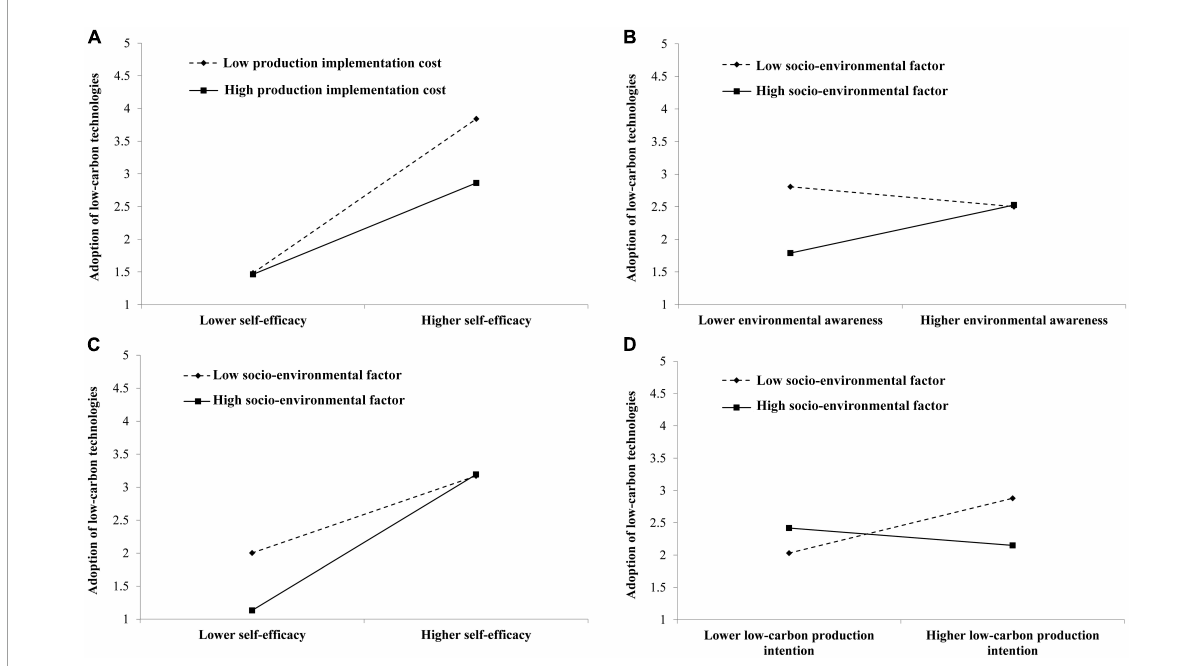
FIGURE4 Moderating effects of production implementation cost and socio-environmental factor. (A) Production implementation cost moderates the effect of self-efficacy on the adoption of low-carbon technologies. (B) Socio-environmental factor moderates the effect of environmental awareness on the adoption of low-carbon technologies. (C) Socio-environmental factor moderates the effect of self-efficacy on the adoption of low-carbon technologies. (D) Socio-environmental factor moderates the effect of low-carbon production intention on the adoption of low-carbon